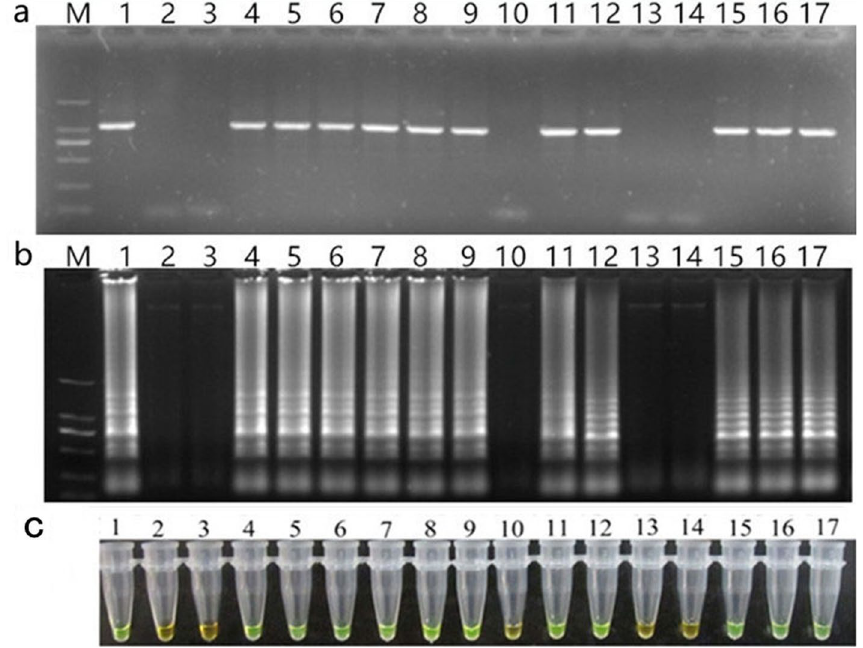
Figure 7. Field applications of PCR and LAMP detection of SVBV. ( a ) Electrophoretic results of the PCR products of 15 strawberry leaf samples in the field; ( b ) agarose gel illustrating the LAMP products of the samples; ( c ) visualization results of the LAMP assay for the samples. Lane M, DL 2000 DNA marker (100– 2000 bp); lane 1, positive control; lane 2, negative control; lanes 3–17, strawberry leaf samples in the field. The full-length gels are presented in Supplementary Fig.